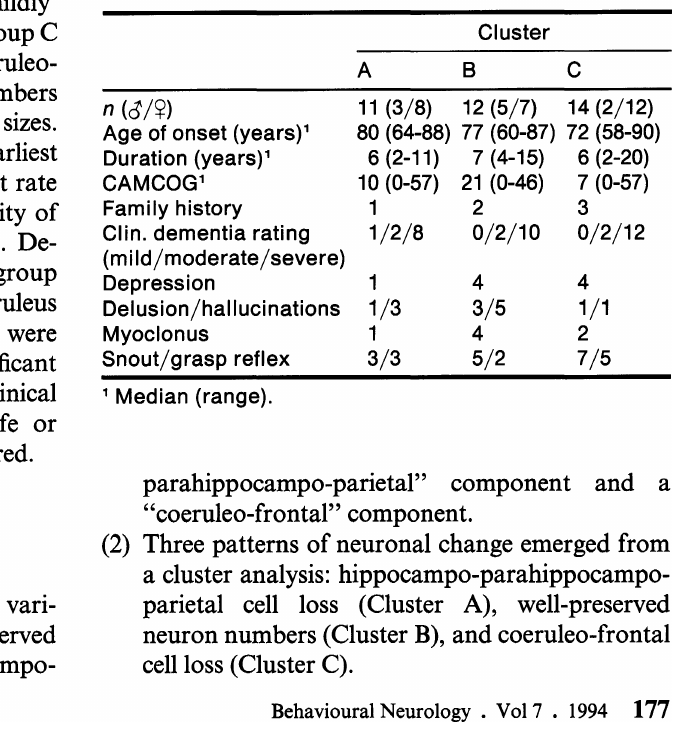
TABLE II. Demographic and clinical features in three clusters of patients with verified Alzheimer's disease. None of the observed differences was statistically signifi cant (p >